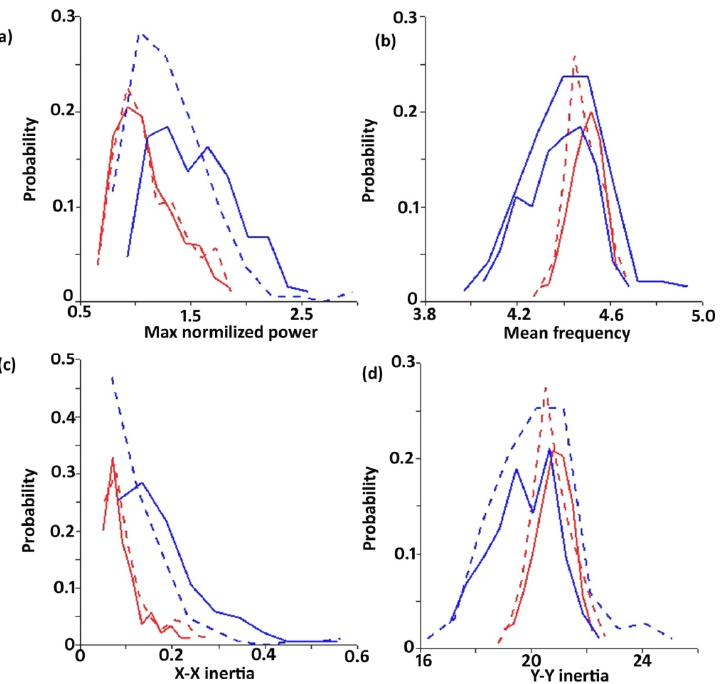
Figure 5. Probability distribution: ( a ) Maximal normalized power [1/kHz]. ( b ) Mean frequency; ( c ) Spectrum inertia about the x-axis. ( d ) Spectrum inertia about y-axis. Red full and dashed lines are sand site 1 and site 2, respectively, while blue full and dashed lines are sandstone site 3 and site 4, respectively.